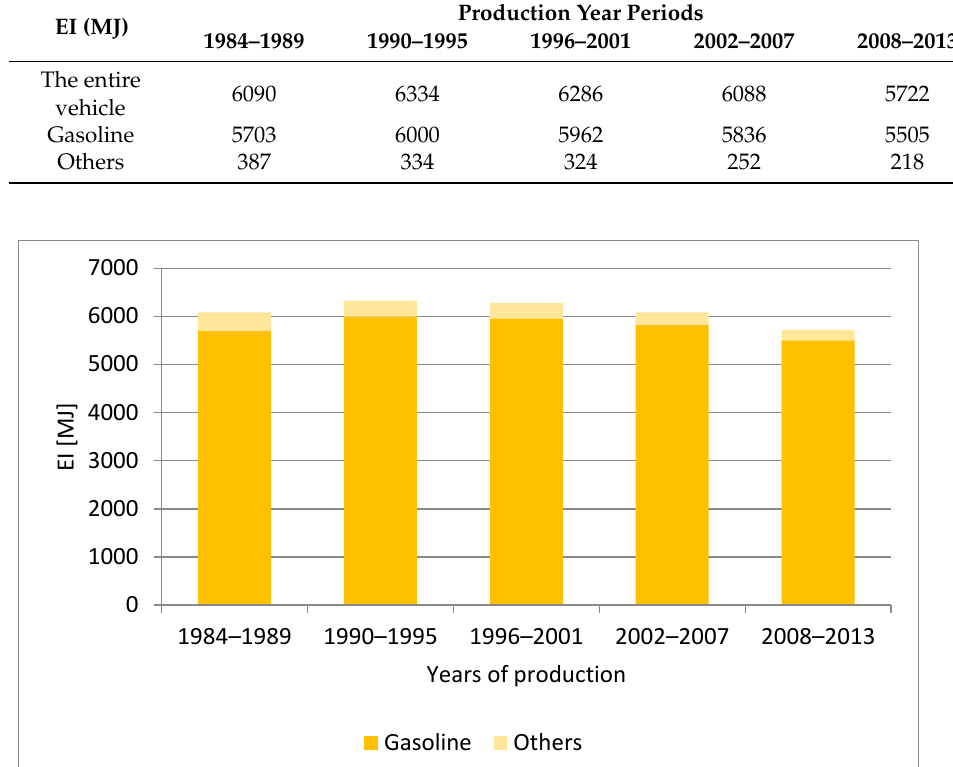
Table 6. Average energy input (EI) in MJ for various production periods.